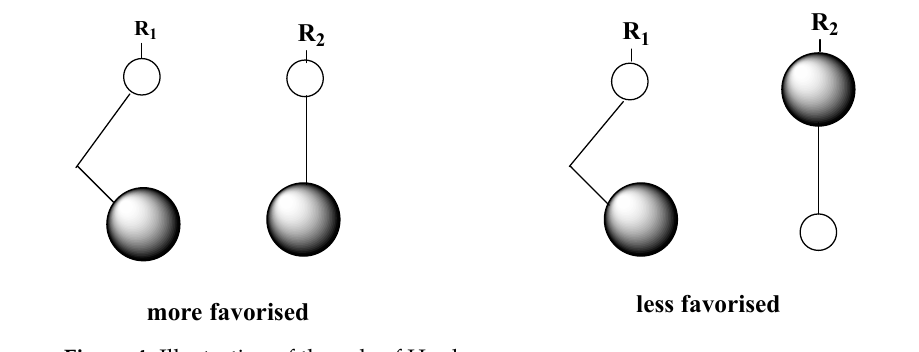
Figure 4. Illustration of the rule of Houk.